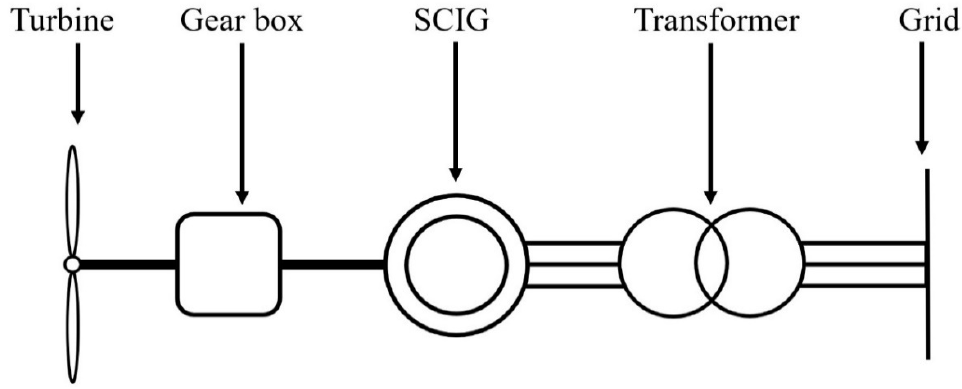
Figure 7. SCIG-based TCG system.